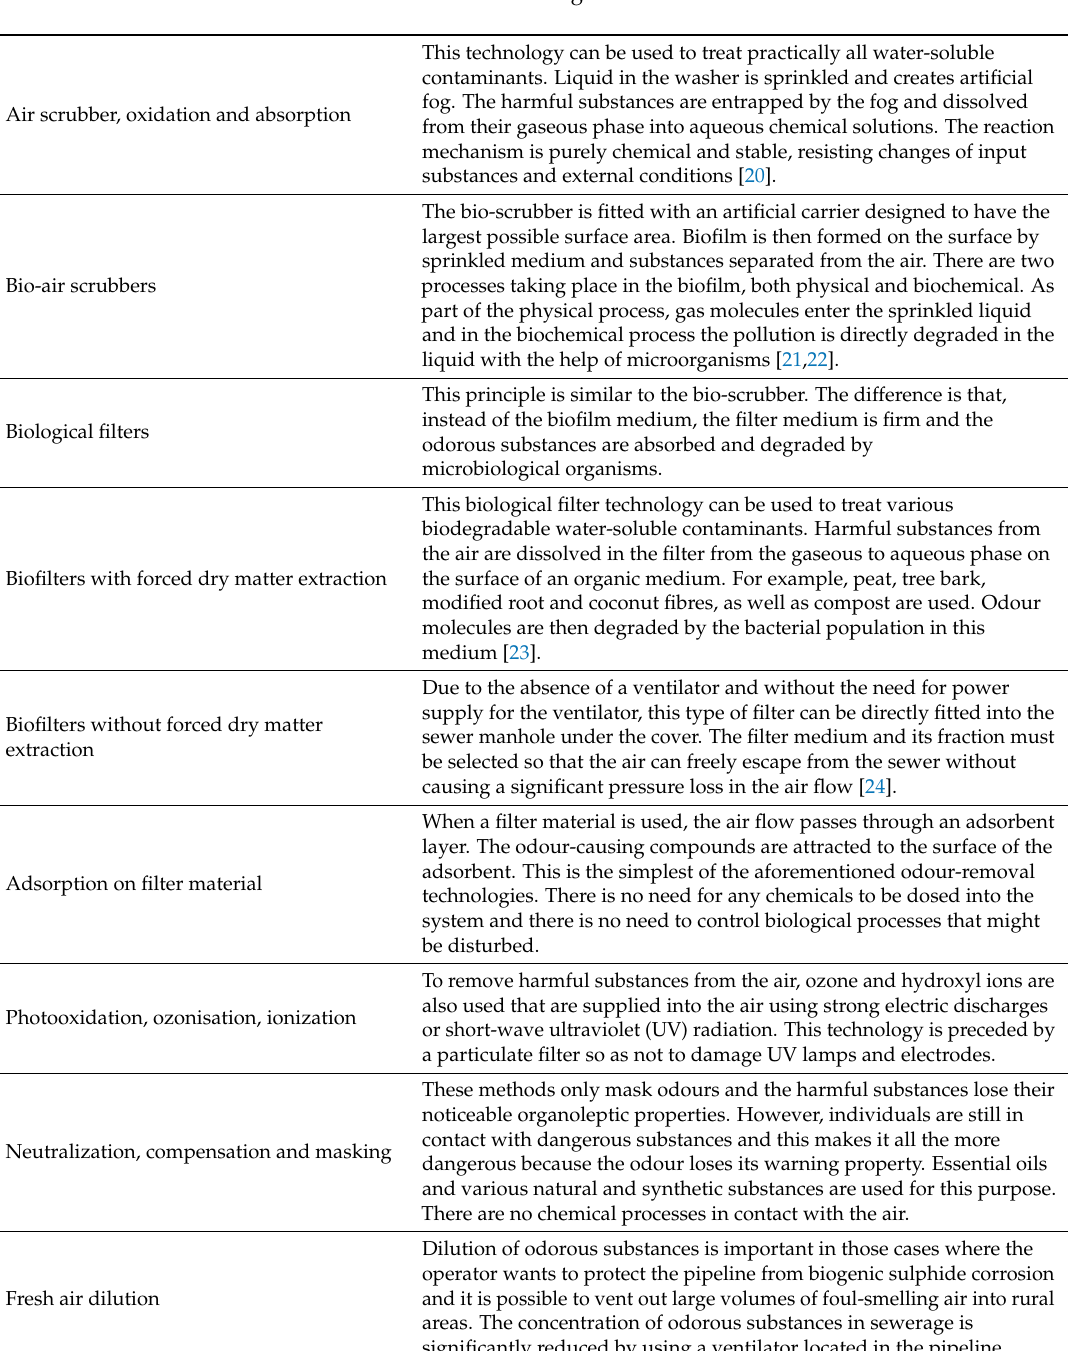
Table 2. Methods of removing odour from the